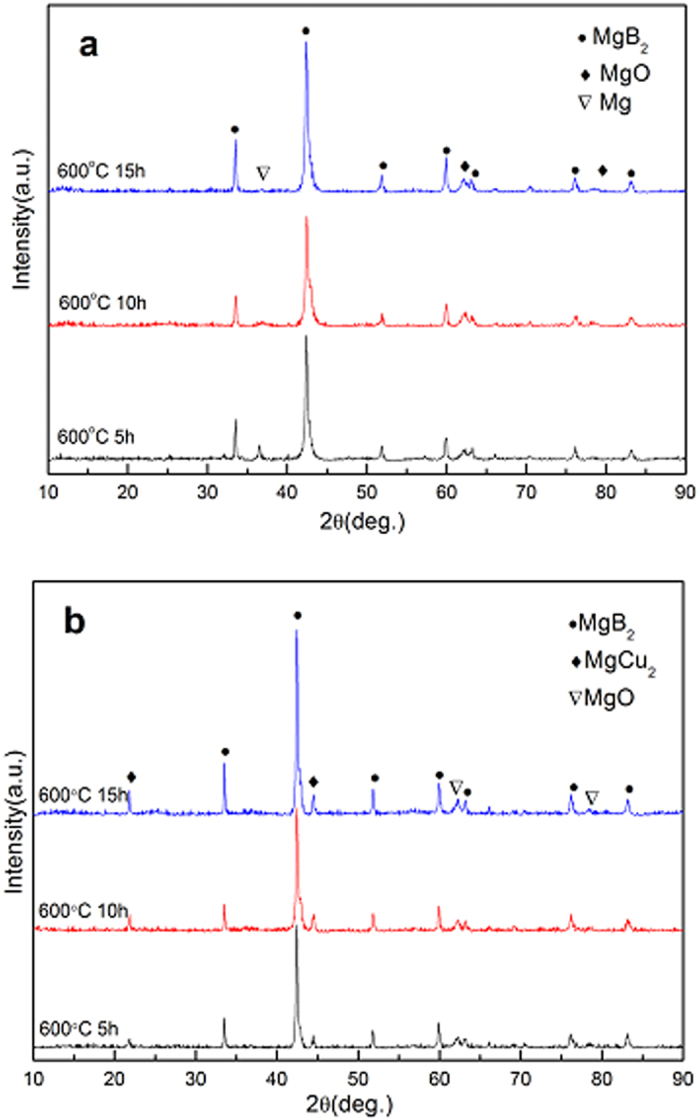
The XRD patterns of samples sintered at 600 °C for different heating time (a) un-doped Mg11B2 and (b) Cu-doped Mg11B2 samples.